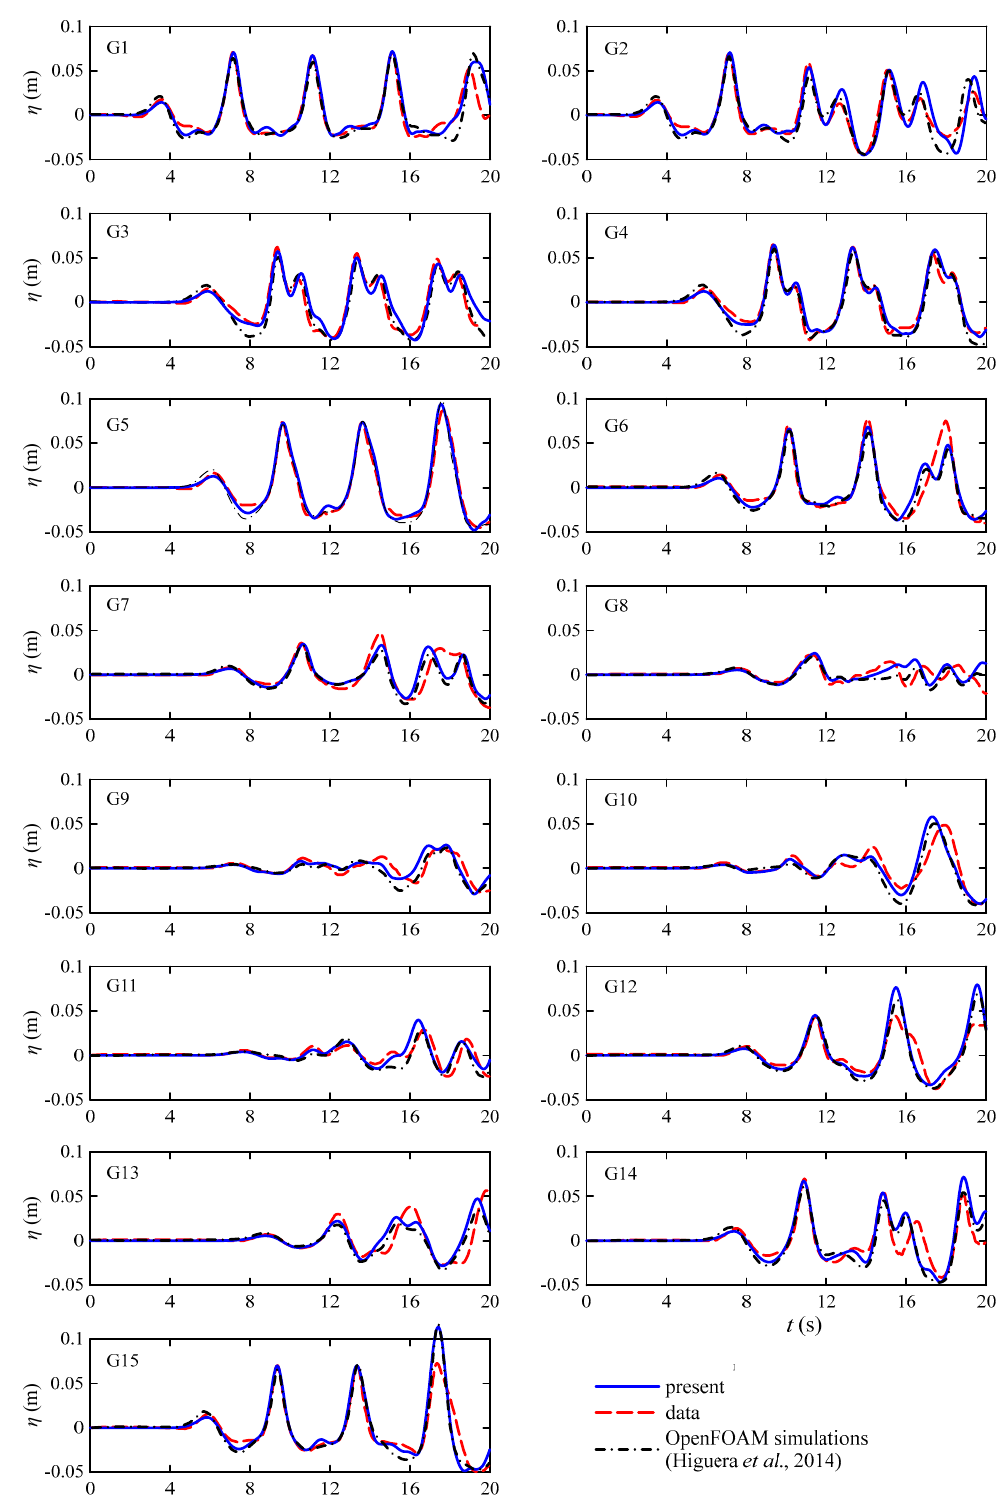
Figure 14. Time series of surface elevation for cnoidal wave propagation through porous breakwater.